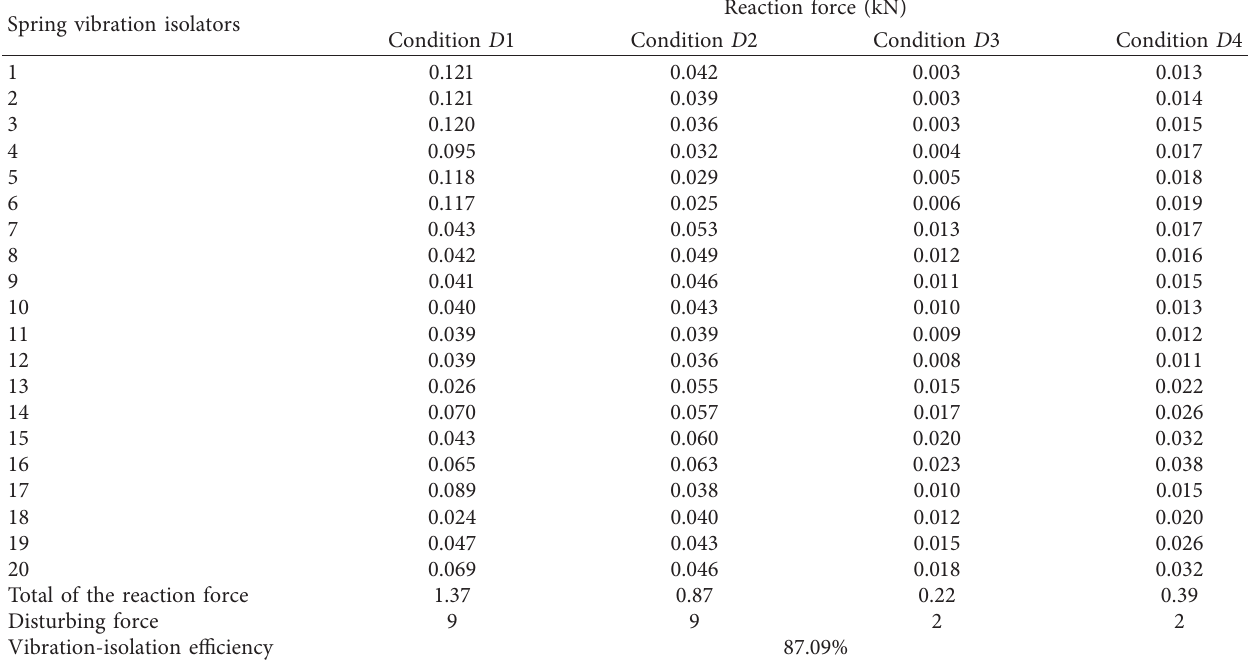
Table 7: Calculated vibration-isolation